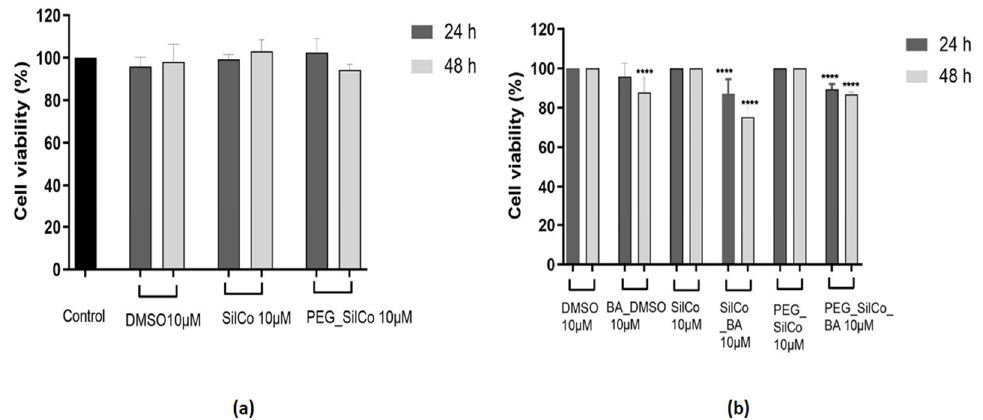
Figure 6. In vitro assessment of silver nanocolloids loaded with betulinic acid effect on A549 cells viability after 24- and 48-h treatment by applying the Alamar blue assay. The data are presented as cell viability percentage (%) normalized to control cells ( a ) and to DMSO, SilCo and PEG_SilCo, respectively ( b ) and are expressed as mean values ± SD of three independent experiments performed in triplicate. To identify the statistical differences between the control and the treated group, one-way ANOVA analysis was conducted, followed by Tukey’s multiple comparisons post-test (**** p <